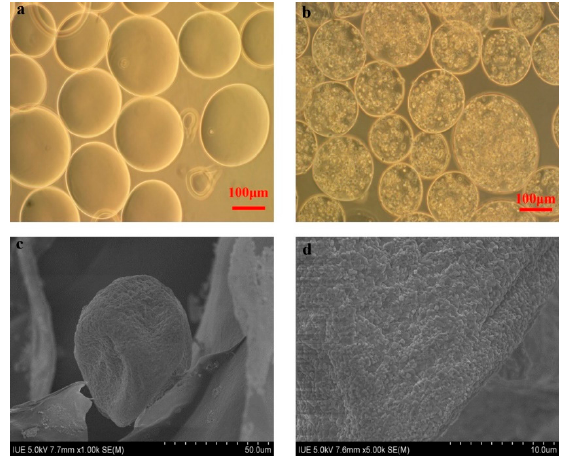
Figure 2. Morphology of blank microcapsules and artificial C5.18 cells. ( a , b ): Optical microscope of blank microcapsules and artificial C5.18 cells; ( c , d ): SEM images of microcapsules with 1000 × and 5000× objective).